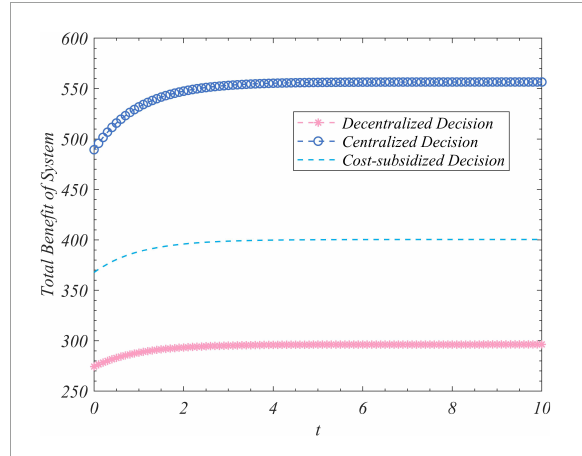
FIGURE5 Trends of the total revenue of the system to correct false information under the decentralized, centralized, and subsidized decision-making